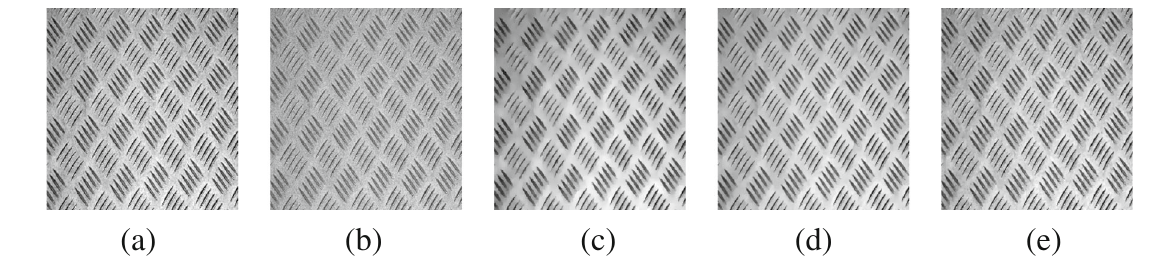
Fig. 10 Experimental results on synthetic texture image; a original image; b noisy image; c restored image by method M1; d restored image by method M2; e restored image by method M3